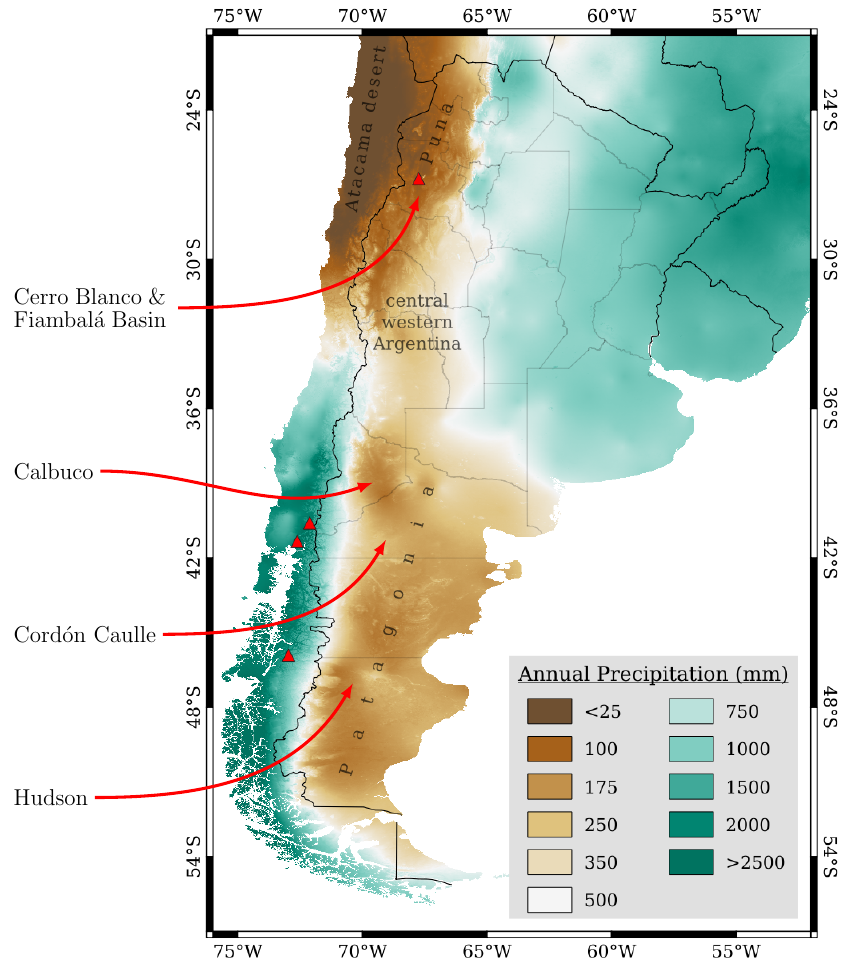
Figure 1. Approximated locations for the major ash-resuspension sources reported in the literature for South America (indicated by red arrows). These areas are concentrated along a continuous band of arid and semi-arid terrains. To illustrate this, the geographic distribution of mean annual precipitation according to the climatic database by Fick and Hijmans [33] corresponding to the 1970–2000 time period is shown. The highlighted sources are associated with the eruption of the key volcanoes indicated by red triangles (from bottom to top): Hudson (1991), Calbuco (2015), Cordón Caulle (2011) and Cerro Blanco ( ∼ 4.2